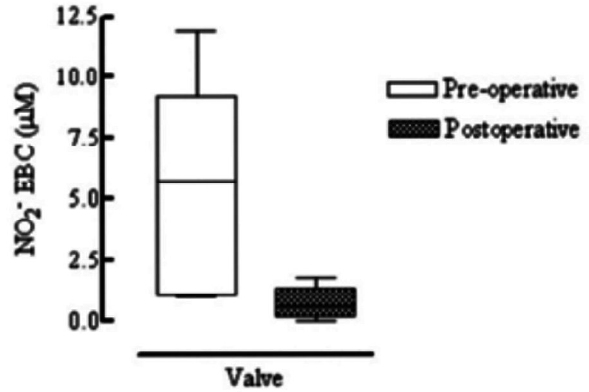
Fig. 2 - Levels of NO 2- EBC in the pre-operative mitral valve disease and postoperative 24 hours